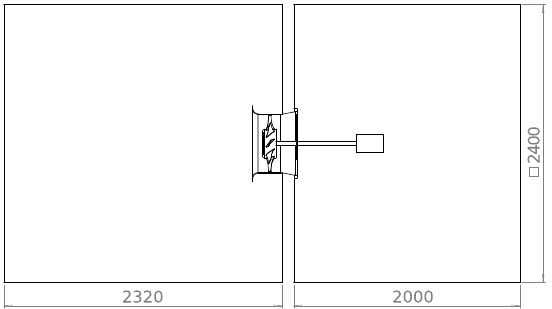
Figure 5. CFD simulation domain with simpli fi ed motor (all dimensions in